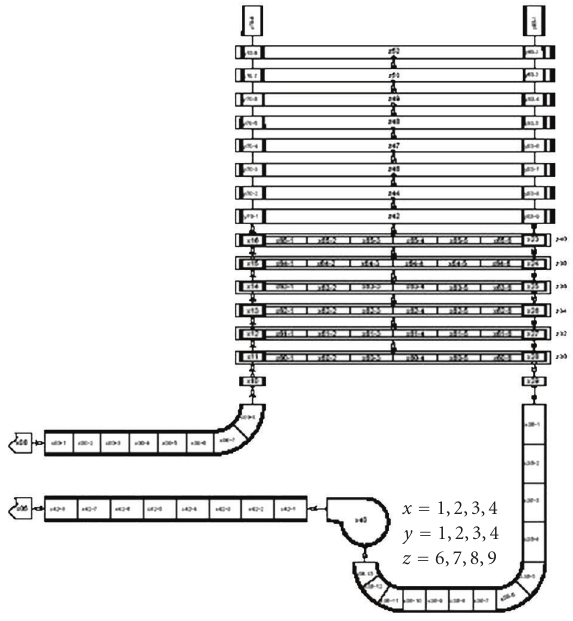
Figure 18: Representative loop input nodalization for VVER-1000.